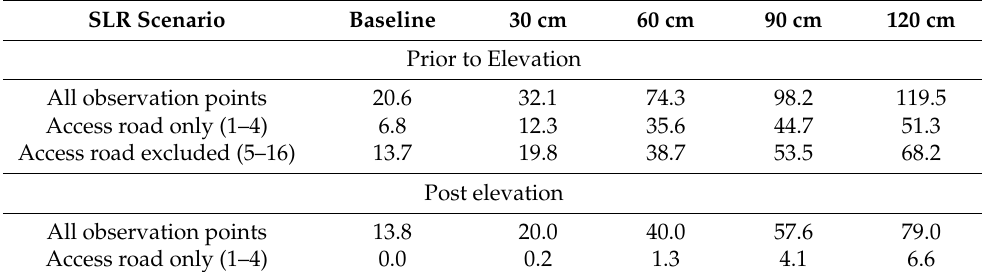
Table 7. AFE (km hours/year) for Hooper Bay.